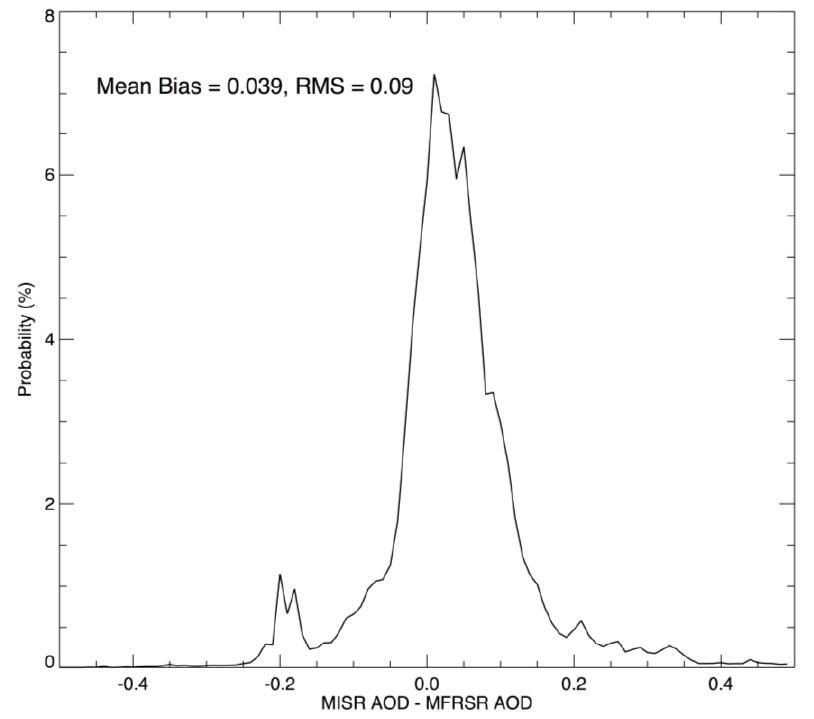
Figure 7. Histogram of AOD difference between MISR and MFRSR for all months of 2003 and 2007, except the SGP